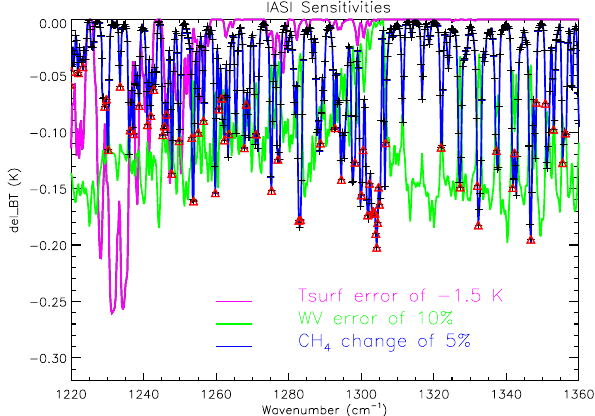
Fig. 1. Change of brightness temperatures (del BT) in the IASI CH 4 band corresponding to a change of surface temperature ( T surf , 1.5K) , water vapor (WV, 10%) and CH 4 (5%) in the tropics using data on 8 November 2009. Red triangles are the channels used in the